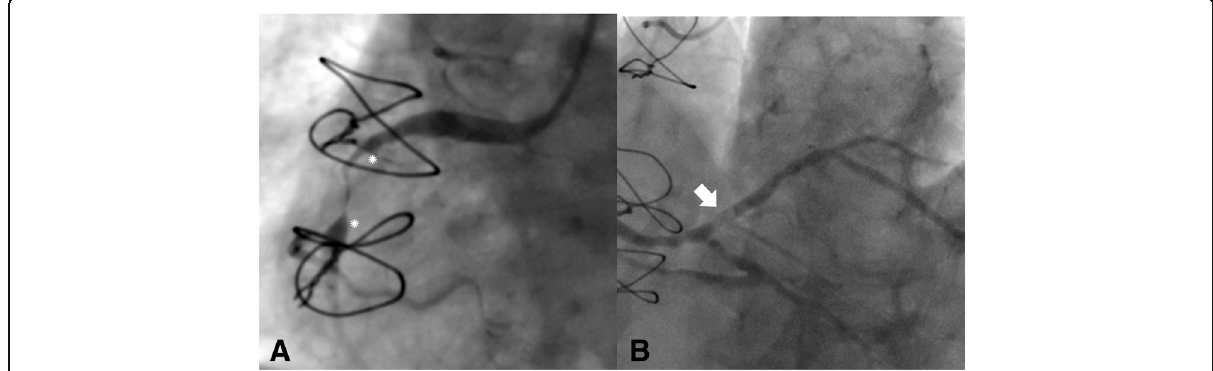
Fig. 1 AP projection of RCA angiogram. a : Tight stenosis is seen in teh mid-proximal RCA (between asterisks). b : Culprit lesion in PLA is a partial filling defect as indicatio by the white arrow